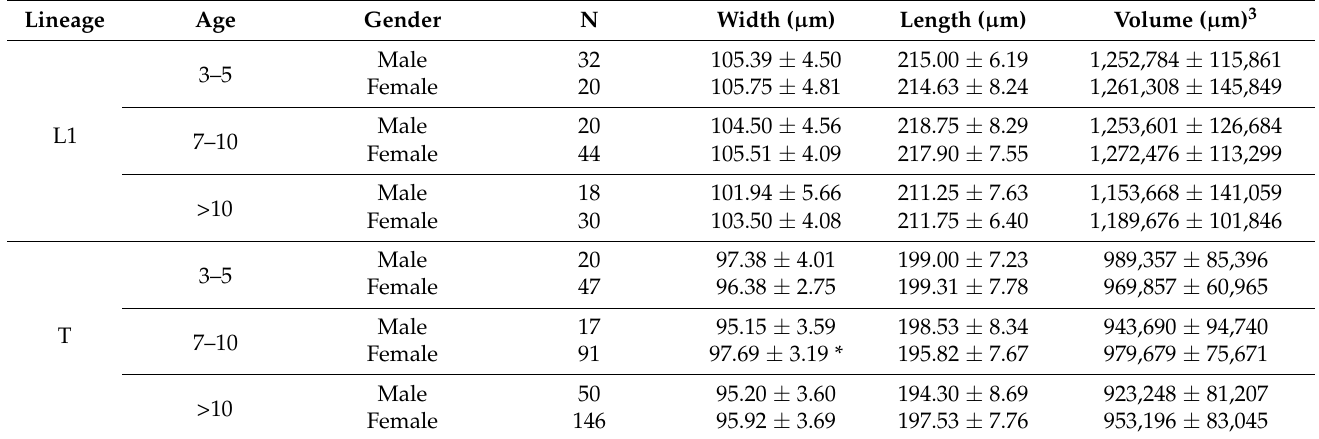
Table 3. Size of male and female eggs produced by mated mothers of the L1 and T lineages in different age